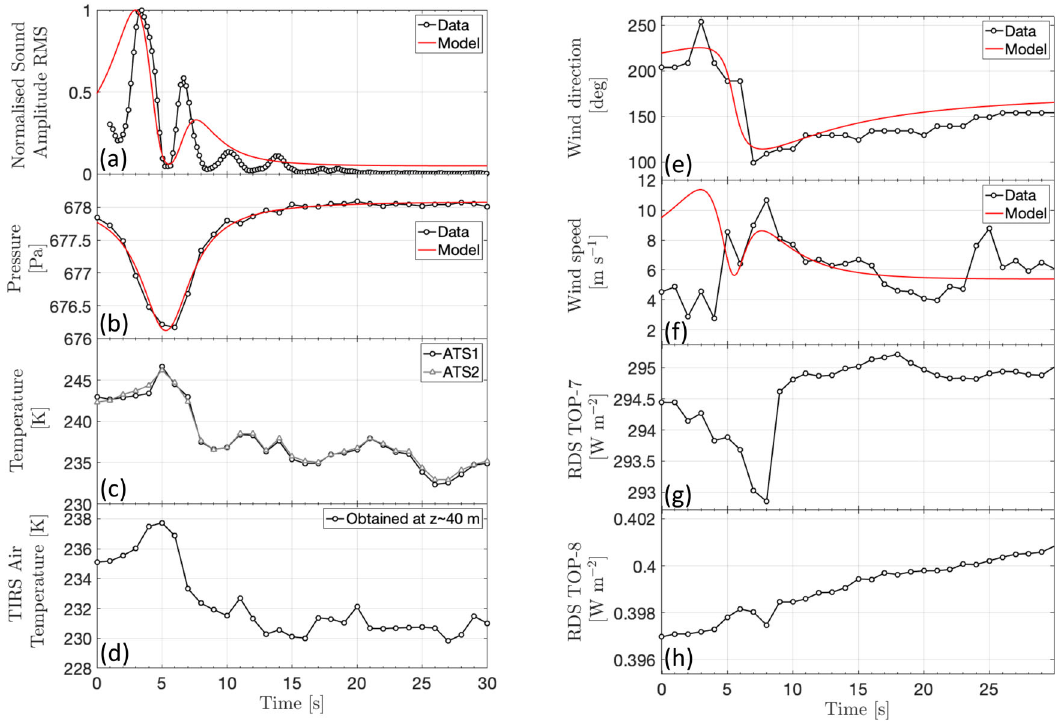
Fig. 2 | Acoustic and multi-instrument recording of the direct dust devil encounter. Data from the SuperCam microphone and the Mars Environmental Dynamics Analyzer (MEDA) instrument during the dust devil encounter. a The normalised microphone sound amplitude Root-Mean-Square (RMS) in the 20 – 60Hz bandwidth calculated in 2-s windows, b the pressure data as measured by the MEDA barometer, c the atmospheric temperature at height ( z )= 1.45m as Table 1. The time is indicated from the start of the SuperCam microphone recording. Source data are provided as a Source Data fi